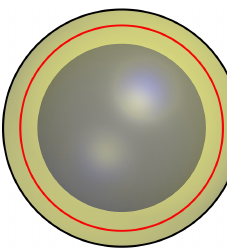
Figure 2. The red surface corresponds to the base surface ( t = 0),and the black and grey color has been assigned to surfaces with ( t = + a ) and ( t = − a ) offsets, respectively. The yellow sphere shell is the volume trapped between t = [ − a , + a ]